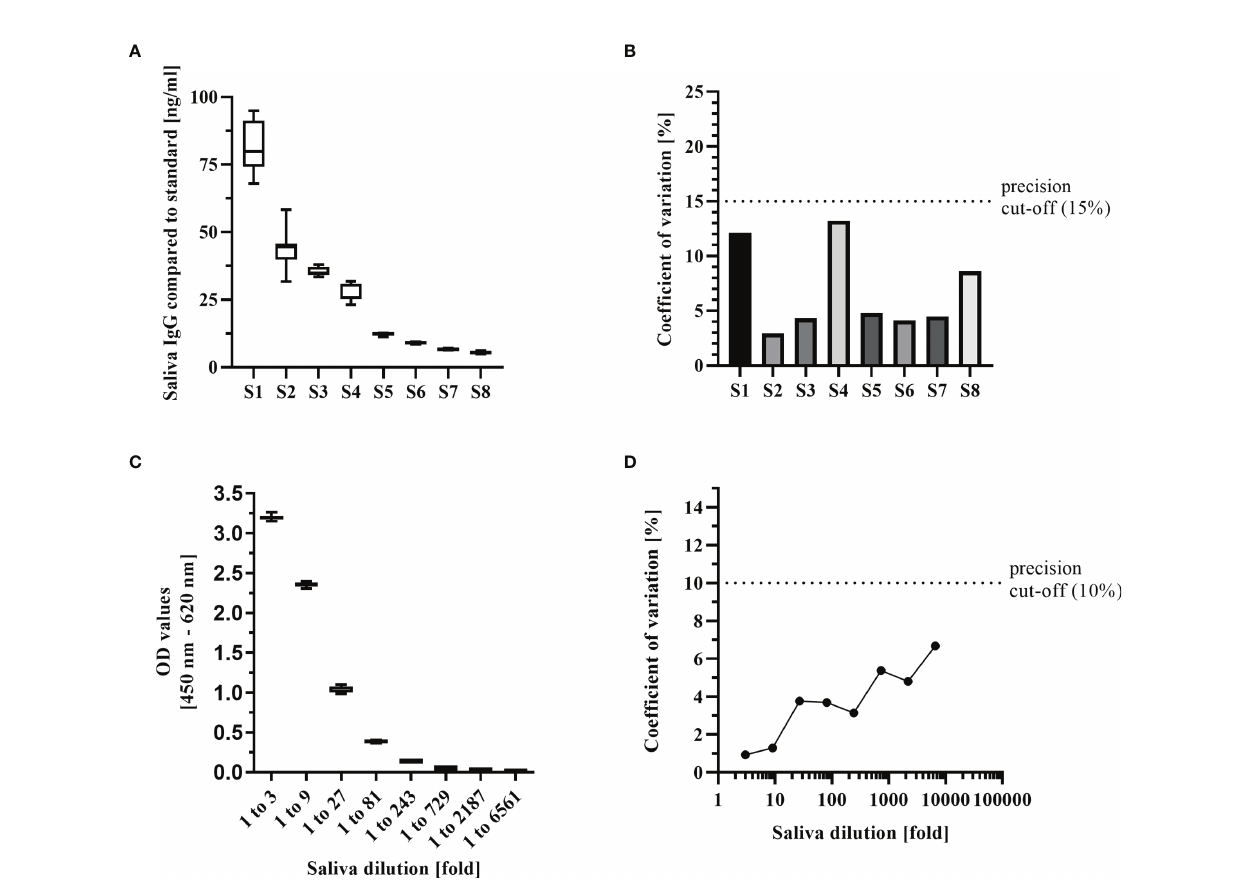
FIGURE 3 | Key performance indicators of the saliva ELISA. (A) Inter-assay precision was estimated by measuring 8 samples in triplicates on 3 different days. Samples were selected to represent a range of IgG concentrations from high to negative. Results are shown as boxplots (median with interquartile range, whiskers represent 1.5x interquartile range). (B) The coef fi cient of variation of the inter-assay was calculated for each of the 8 samples. (C) Intra-assay precision was estimated by measuring a positive sample in 12 replicates with 8 3-fold dilutions and represented as boxplots. (D) Coef fi cient of variation of the intra-assay was calculated for each of the 8